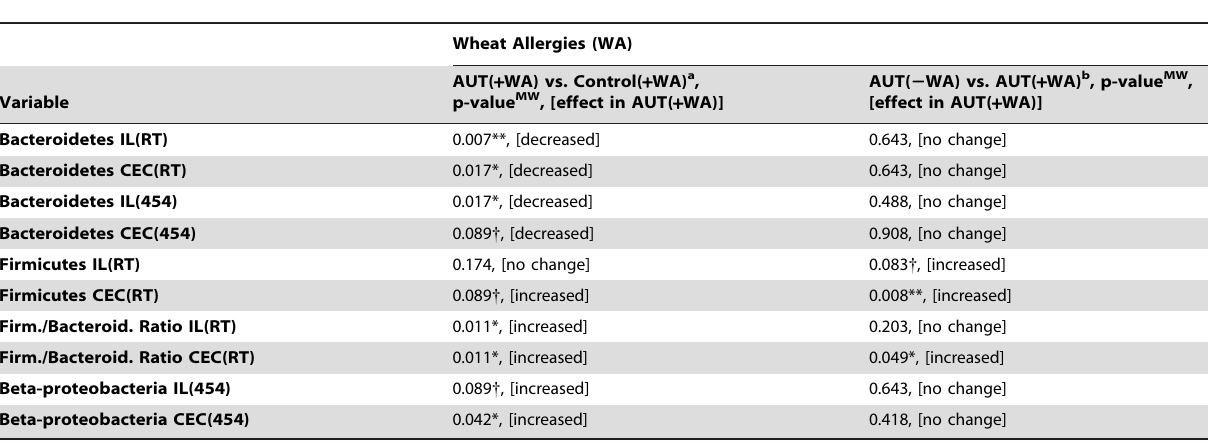
Table 7. Association of wheat allergy (WA) with host gene expression and bacterial phylotypes in AUT-GI children.